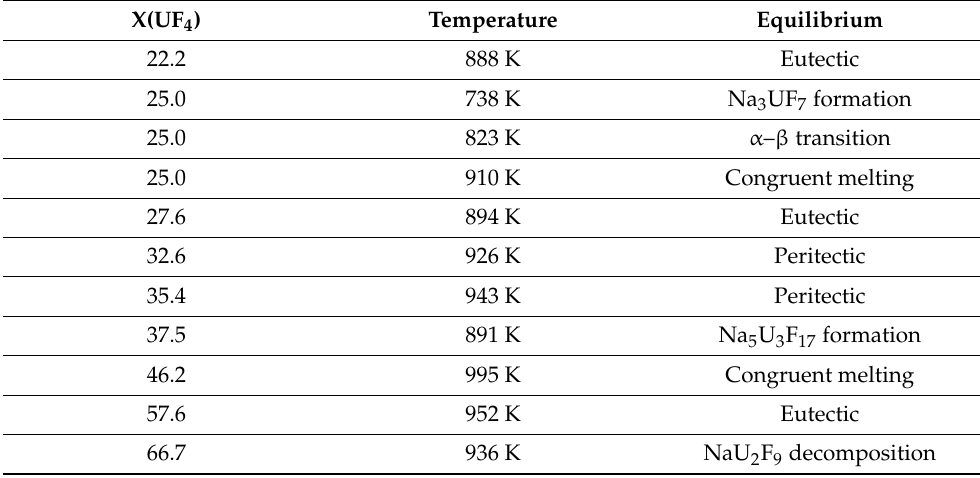
Table 6. Invariant equilibria obtained from the calculated NaF-UF 4 phase diagram.